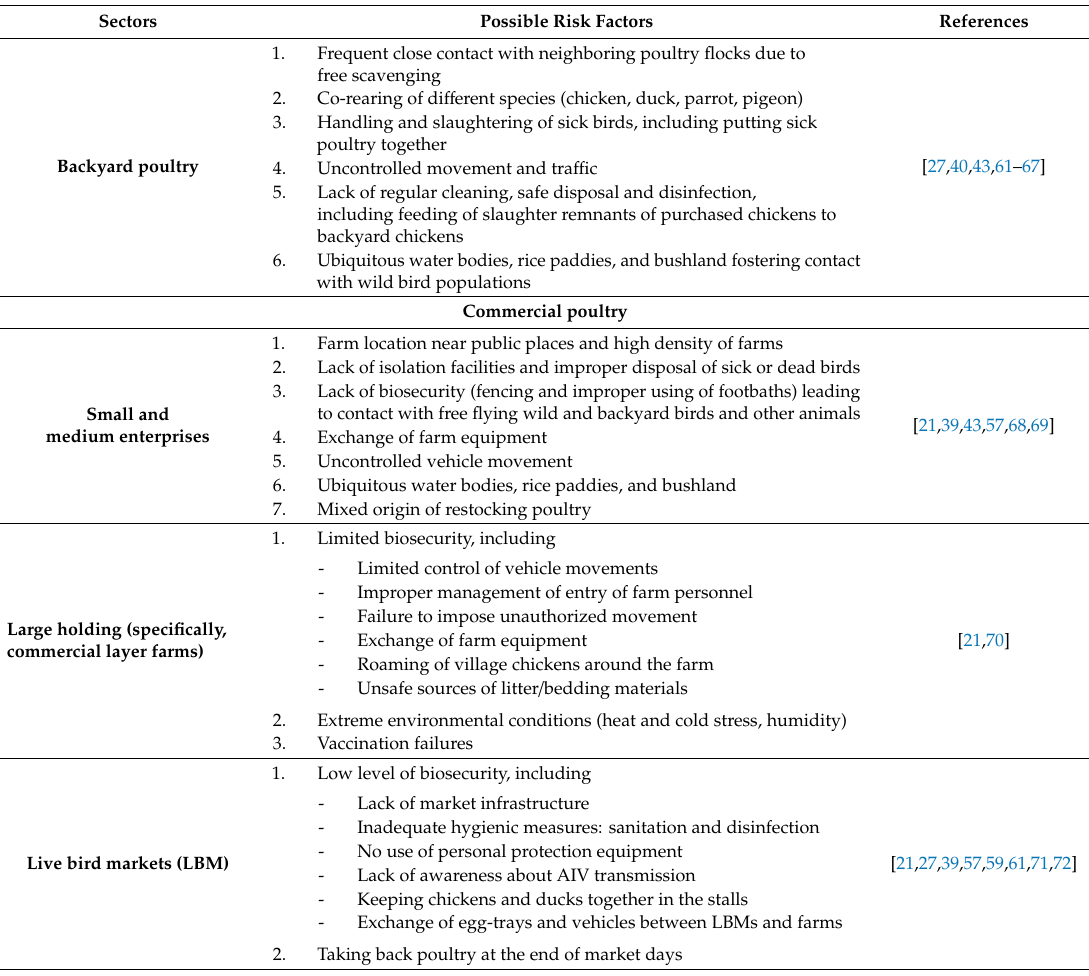
Table 1. Risk factors identified in the Bangladeshi poultry farming and marketing systems that may promote spread of avian influenza virus